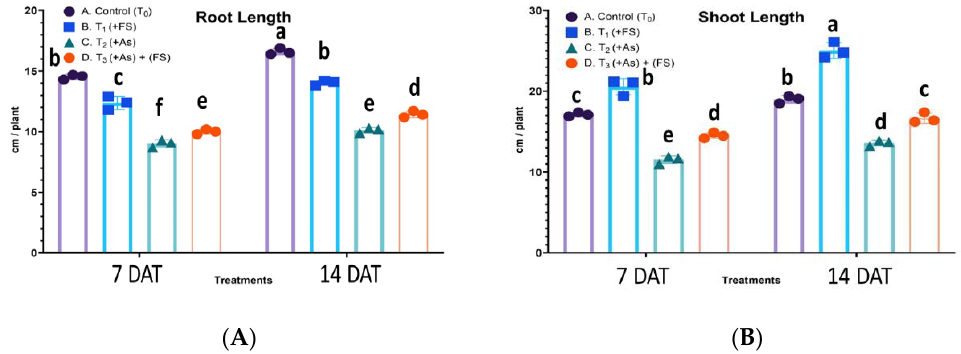
Figure 2. ( A , B ): Impact of iron sulfate (T 1 : +FeSO 4 ), arsenic stress (T 2 : +As) and FeSO 4 supplementation during As stress (T 3 : As+FeSO 4 ) on the root ( A ) and shoot ( B ) lengths of Brassica juncea studied 7 and 14 days after treatment (DAT). The values are mean ± SE and n = 3. Different letters on the bars indicate significant changes ( p < 0.05) in different treatments as determined by Tukey’s HSD test. As, Arsenic; FS, FeSO 4